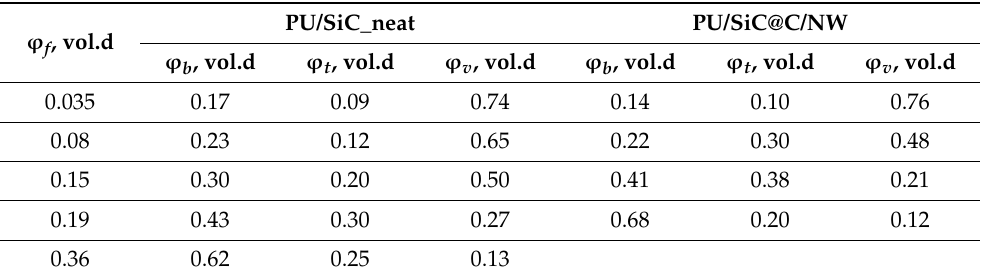
Table 3. The values of the polymer’s volume fractions, spending on the formation of the boundary, transition and volume layers of the matrix with the filler’s certain proportion in the composite. PU/SiC_neat PU/SiC@C/NW ϕ f , vol.d ϕ b , vol.d ϕ t , vol.d ϕ v , vol.d ϕ b , vol.d ϕ t , vol.d ϕ v ,